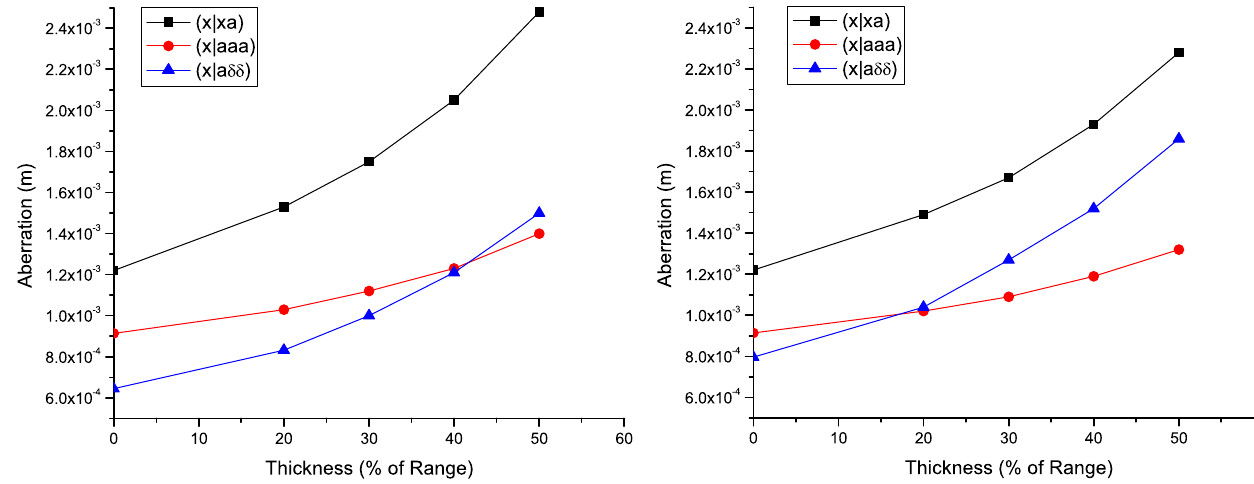
FIG. 8. (Color) The largest remaining aberrations in the system after multipole correction and wedge shaping performed to third order. All aberrations are initial horizontal angle dependent and become larger with increasing wedge thicknesses. The variation with energy is small: 200 MeV = u case on the left and 400 MeV = u on the right.